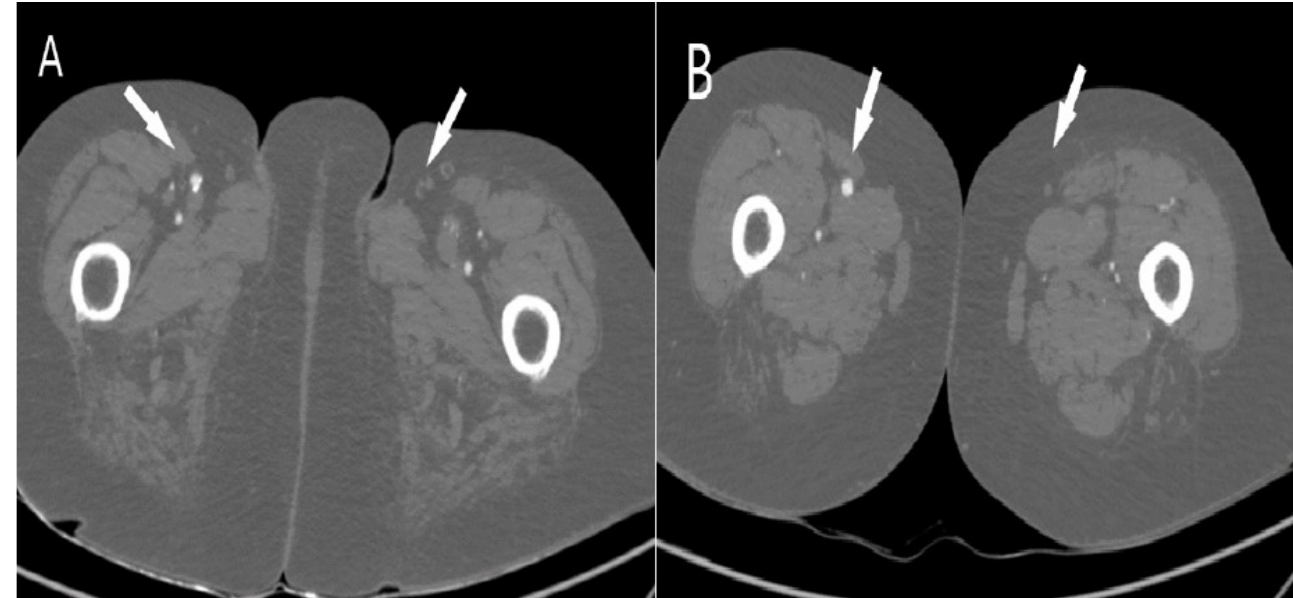
Figure 2. Axial computed tomography angiography shows ( A ) occlusion of the left common femoral artery (white arrow) and ( B ) shows occlusion of the left superficial femoral artery (white arrow).